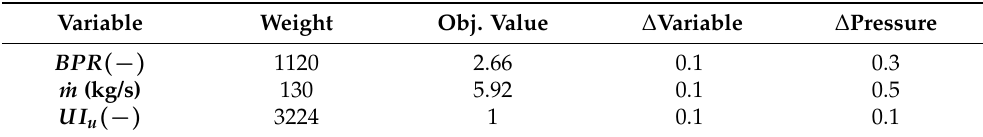
Table 3. Weights of the cost